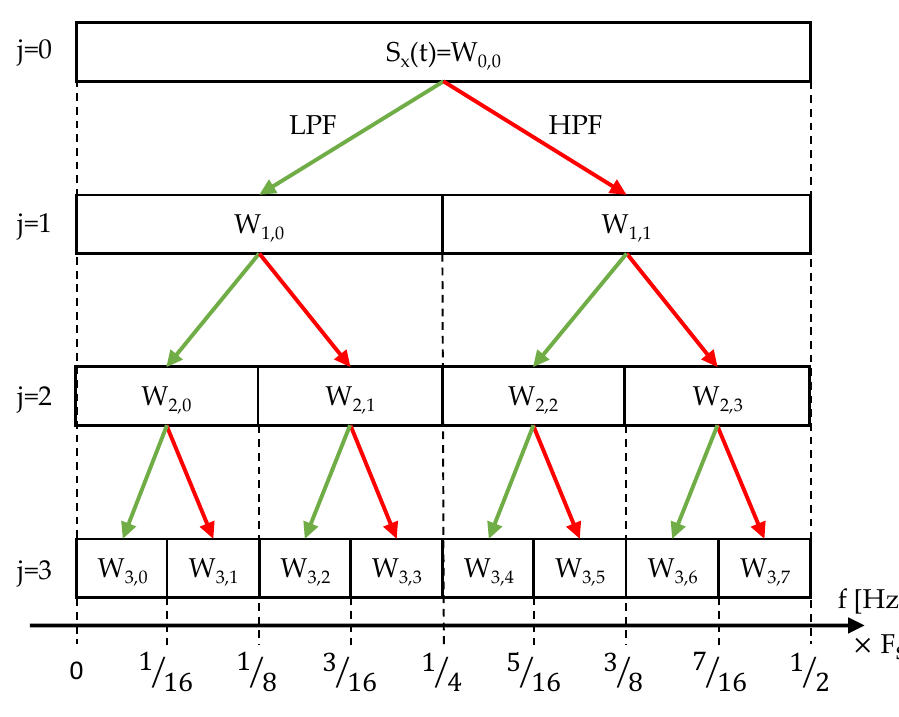
Figure 4. UWPT decimation